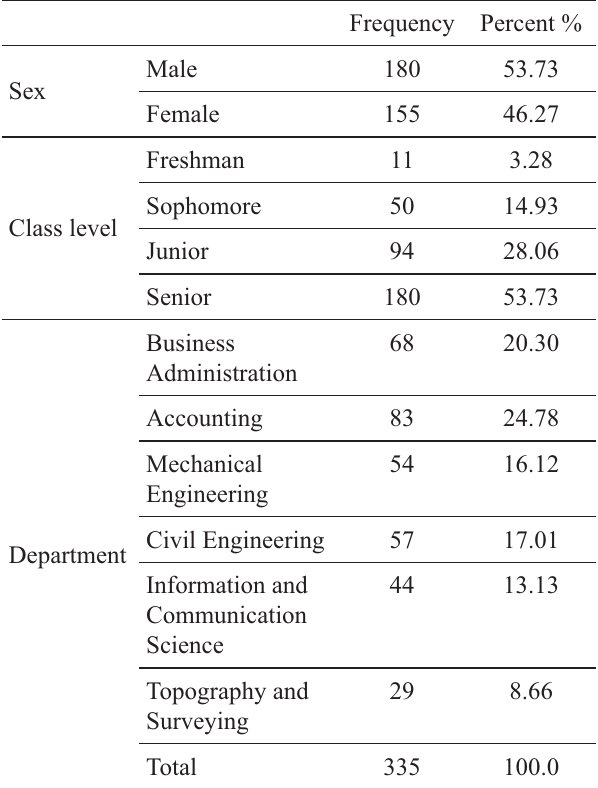
Table 1. Students sample description